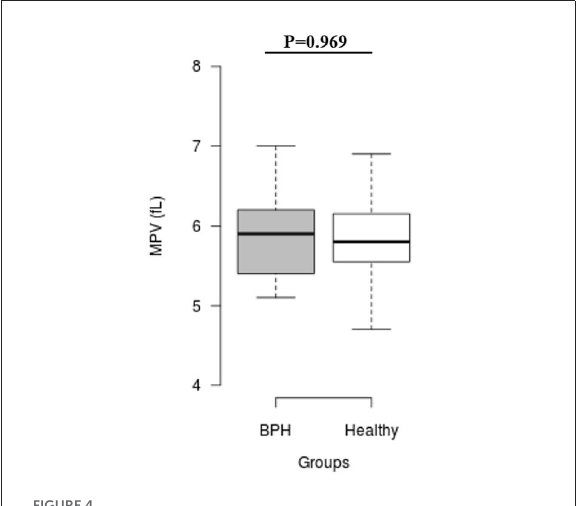
FIGURE4 Box plots of mean platelet volume (MPV) in BPH and Healthy groups. Center lines show the medians; box limits indicate the 25th and 75th percentiles. n = 24, 11 sample points.